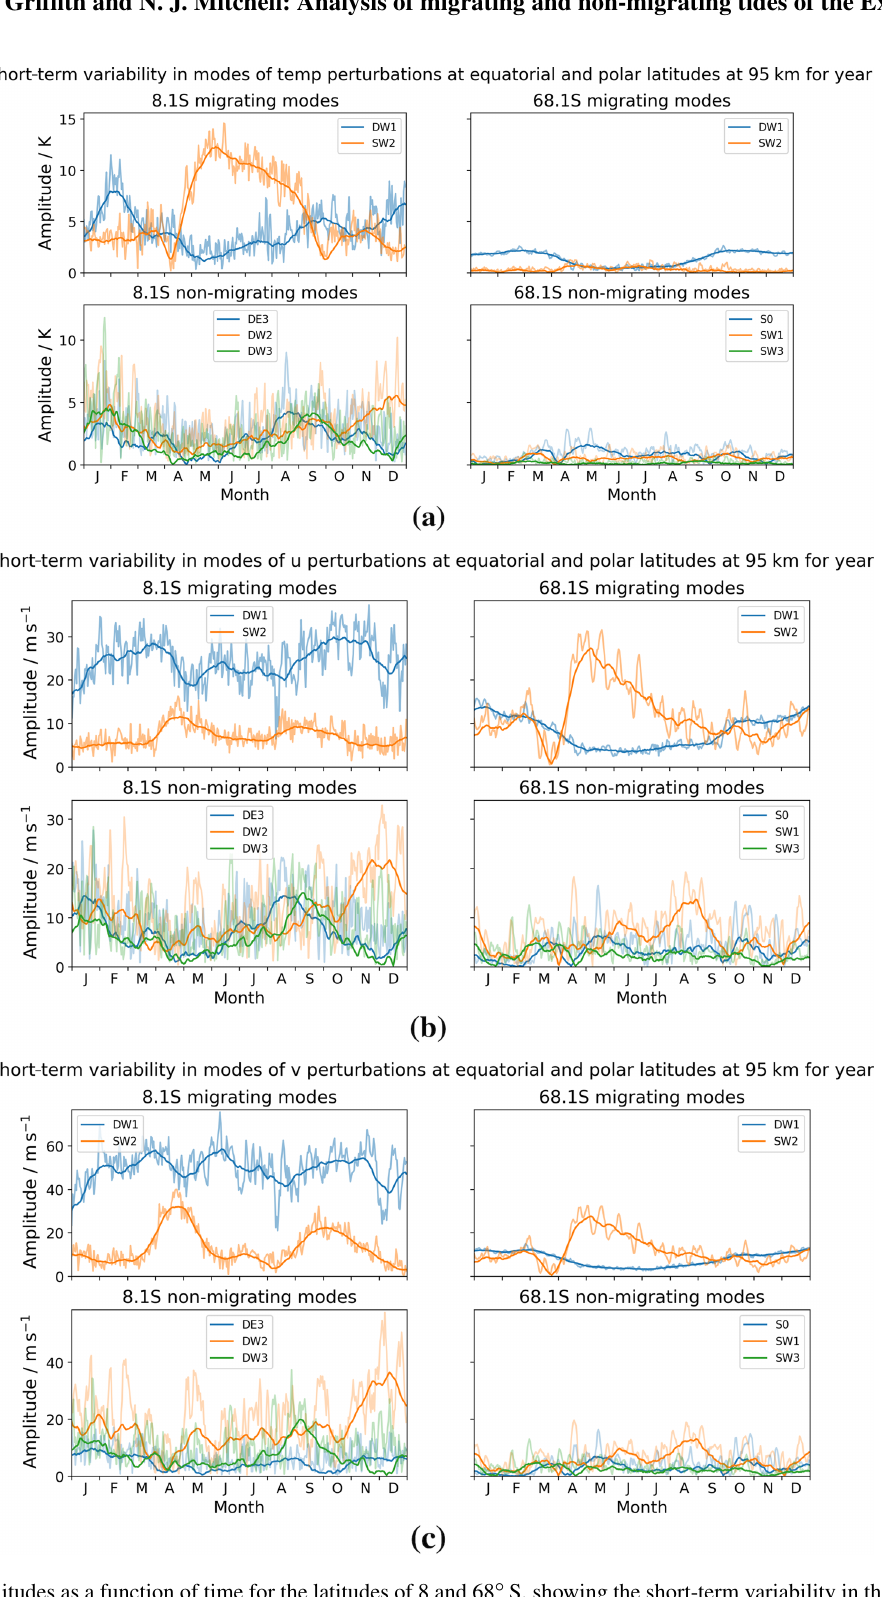
Figure 14. Tidal amplitudes as a function of time for the latitudes of 8 and 68 ◦ S, showing the short-term variability in the migrating compo- nents and largest non-migrating tidal components over the course of the year for (a) temperature, (b) zonal ( u ) winds, and (c) meridional ( v ) winds. The bold line represents the value from the 30d sliding window, and the faded line represents the value obtained using the 1d sliding